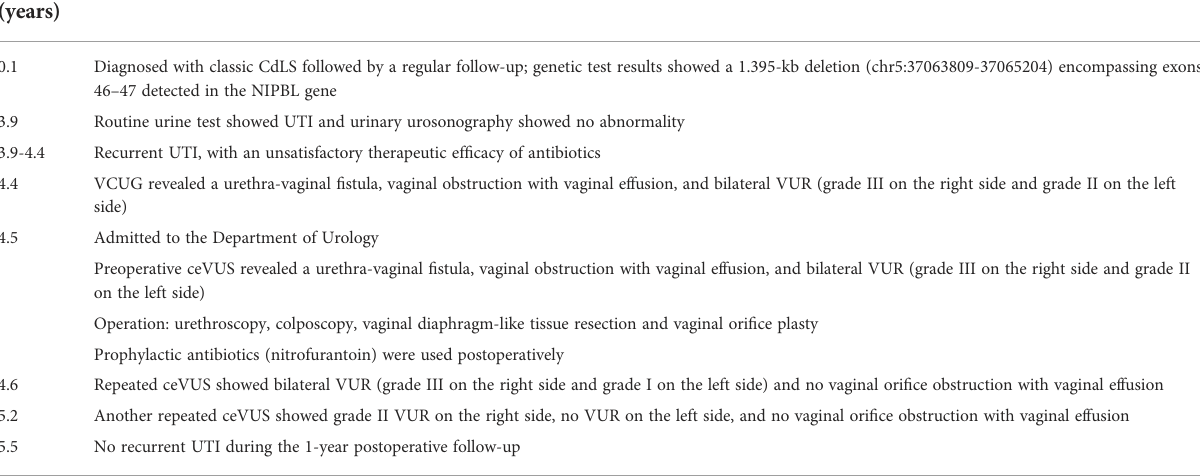
TABLE 1 Relevant clinical features, investigations, and treatment from the episode of care according to timeline. Age (years)